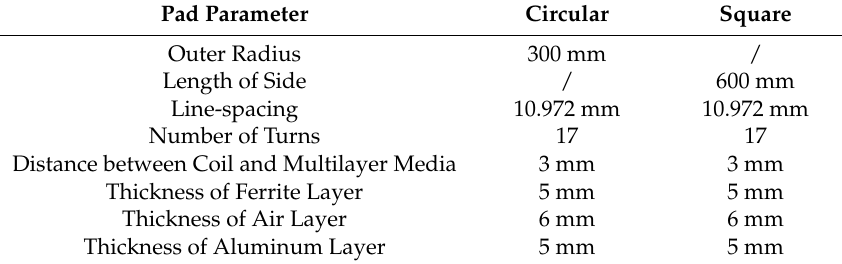
Table 3. Parameters of the spiral coils.